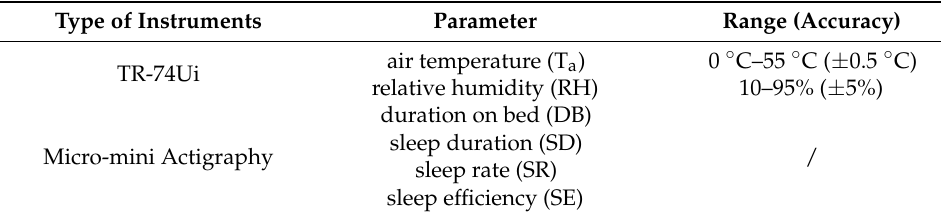
Figure 2. Experimental procedure. Table 1. Types of instruments and parameters.